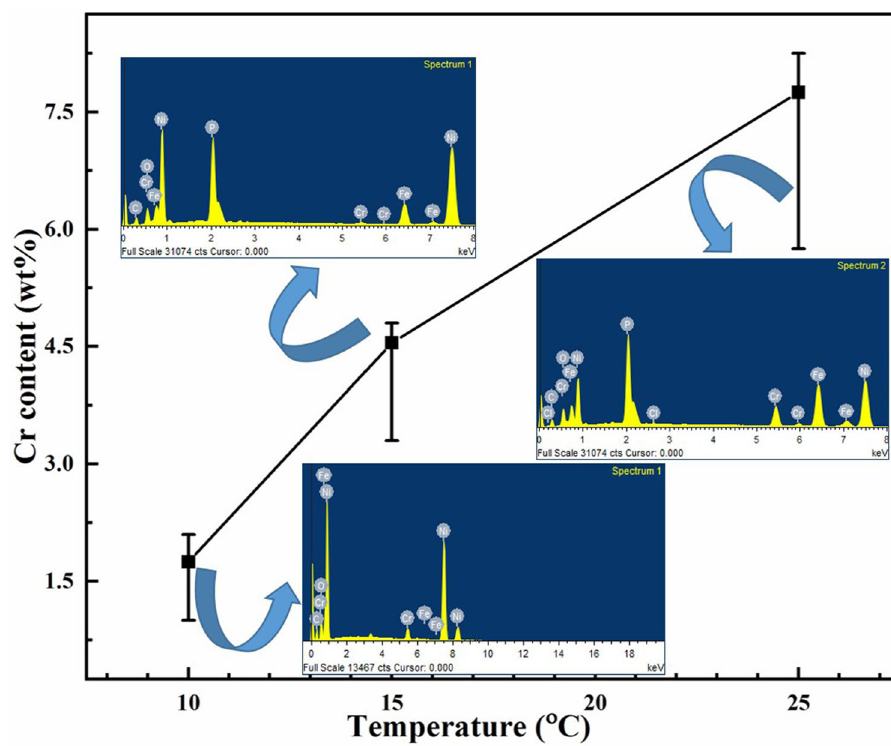
Fig. 5 Variation of chromium content with temperature during Ni–Cr–P